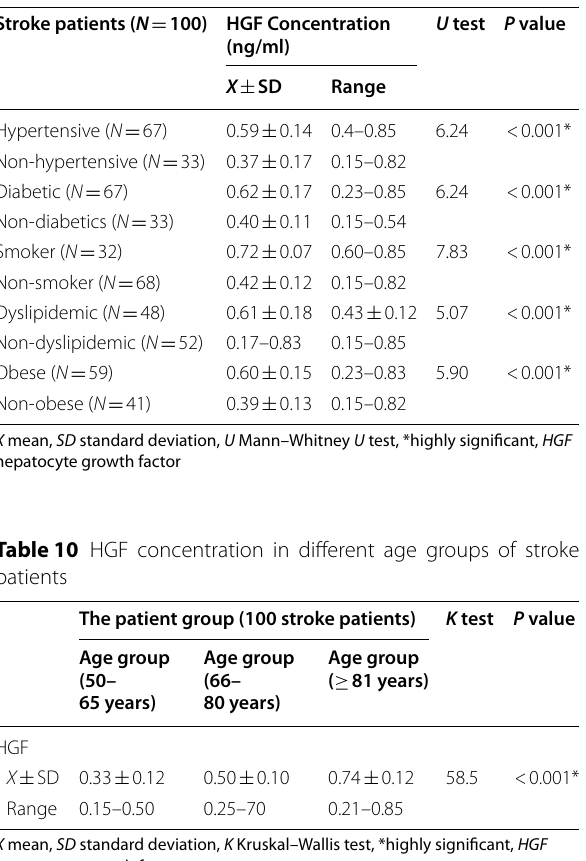
Table 9 The concentration of HGF level in stroke patients with and without vascular risk factors